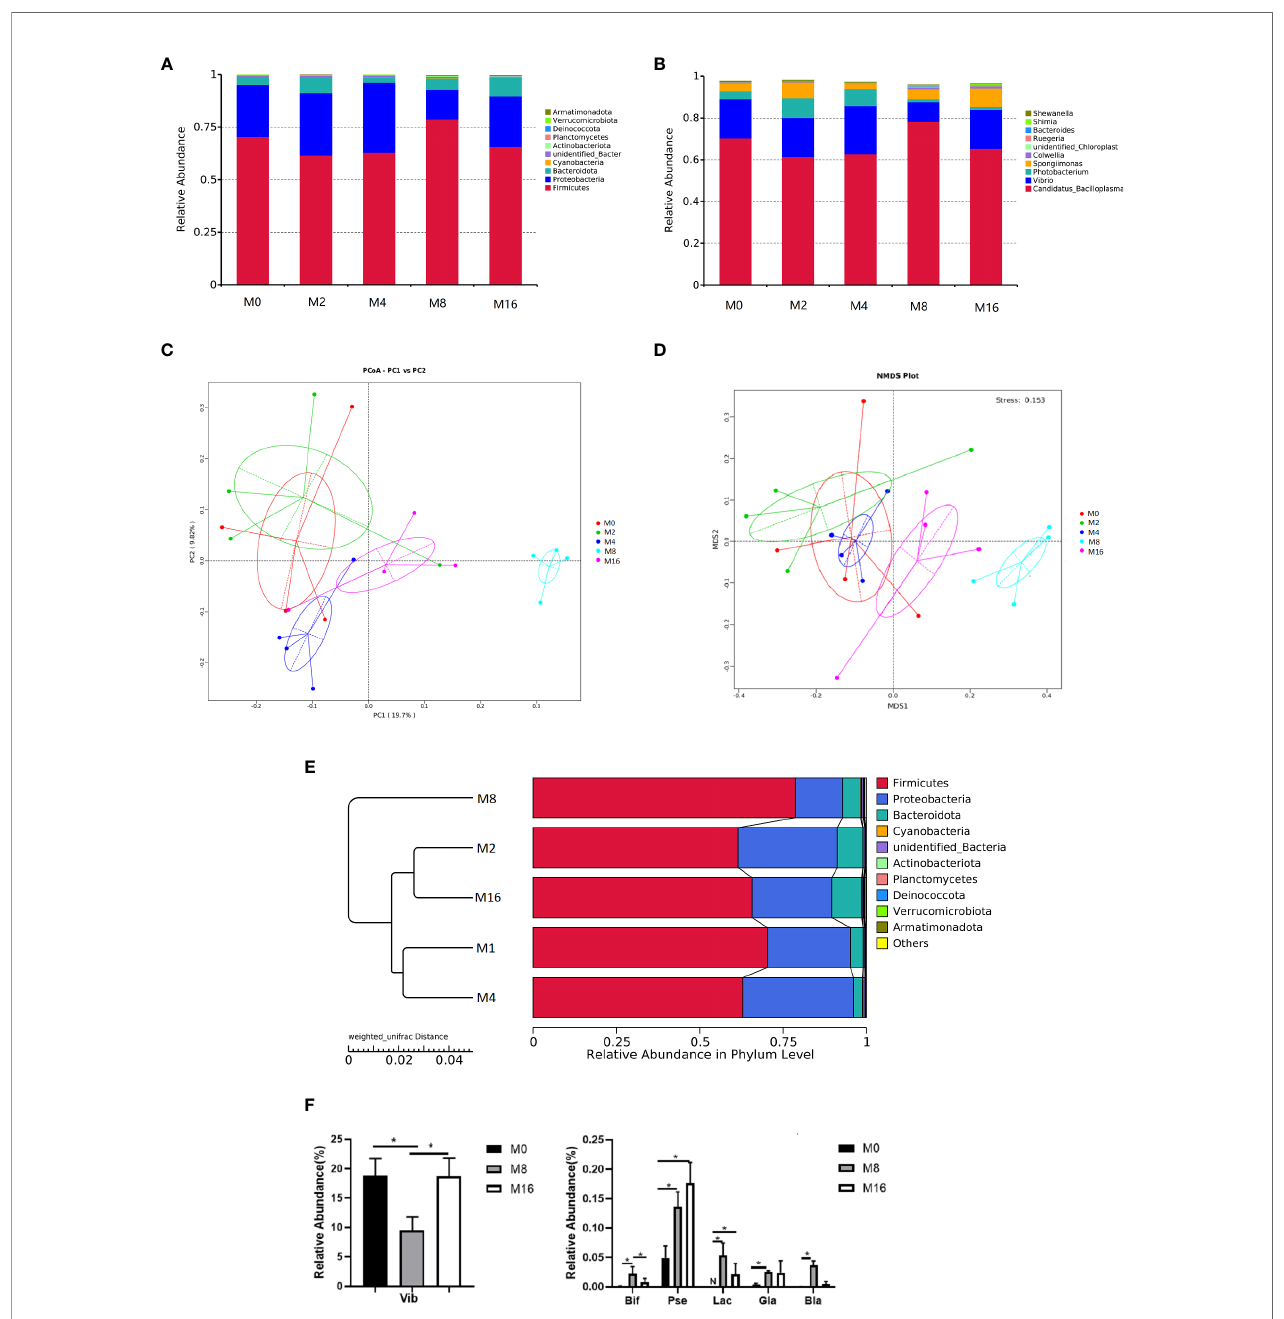
FIGURE 6 | Effects of dietary MOS on the intestinal microbiota. Taxonomy classi fi cation of reads at the phylum (A) and genus (B) taxonomic levels. Only the top 10 most abundant (Based on relative abundance) bacterial phyla and genera are shown in the fi gures; other phyla and genera were all assigned as “ Others. ” Beta diversity of intestinal microbiota of Litopenaeus vannamei . (C) Principal coordinates analysis (PCoA). (D) Non-metric multidimensional scaling (NMDS), and (E) unweighted pair group method with arithmetic mean (UPGMA)-clustering trees based on unweighted UniFrac distance. (F) Some signi fi cantly changed abundance at genus level in M0, M8, and M16. *Signi fi cant difference between treatments ( p < 0.05). Vib, Vibrio ; Bid, Bi fi dobacterium ; Pse, Pseudoalteromonas ; Lac, Lactobacillus ; Gla, Glaciecola ; Bla, Blautia ; MOS, mannan